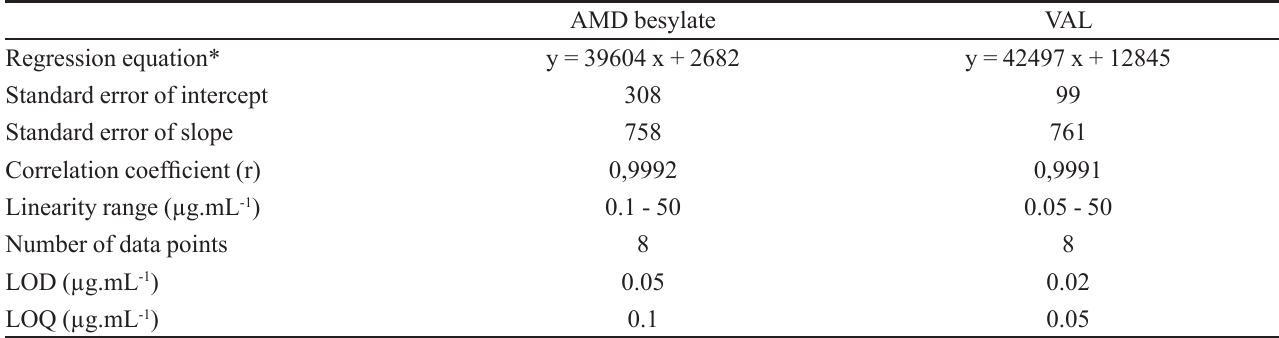
TABLE I - Linearity data of the developed method (n=6)